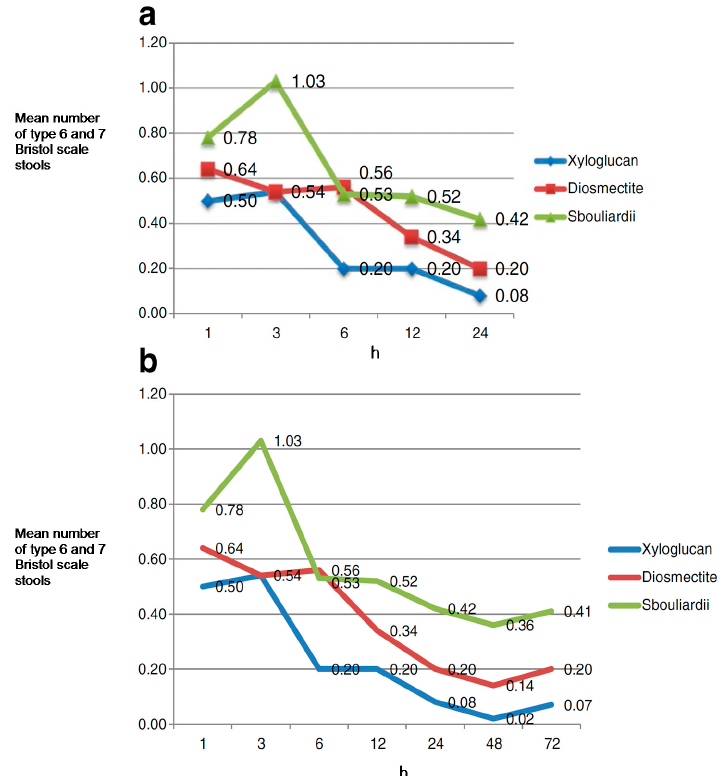
Figure 5. Clinical evolution of diarrhoeal symptoms (mean number of type 6 and 7 Bristol scale stools, the most dehydrating type of stools) among groups (xyloglucan, disomectite and Saccharomyces boulardii ). ( a ) Mean number of type 6 and 7 stools during the first 24 h. ( b ) Mean number of type 6 and 7 stools during the study period (three-day treatment)